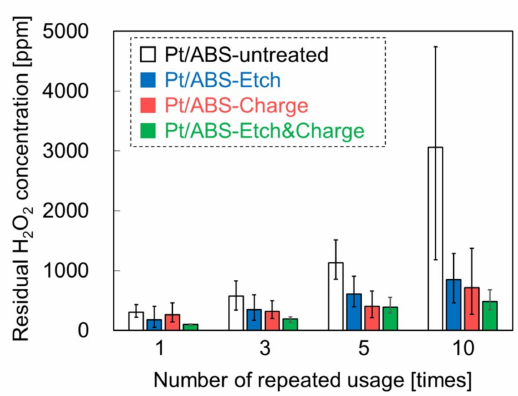
Figure 7. Catalytic durability of the Pt/ABS samples: relation between the number of repeated uses and the residual H 2 O 2